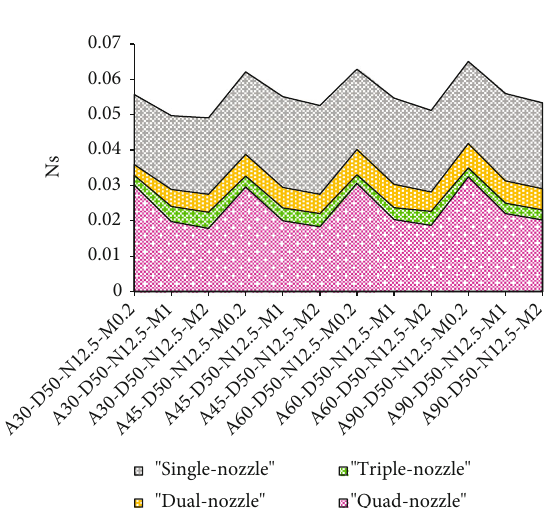
Figure 4: Entropy generation due to frictional source.